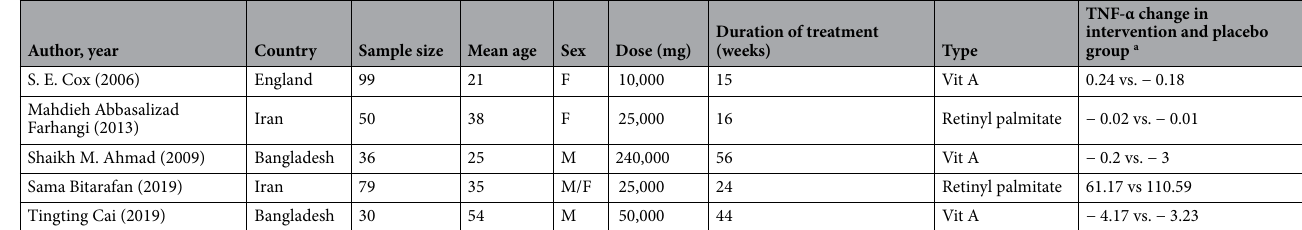
Table 2. The characterized of studies that included TNF-α analysis. Summary of clinical trials on the effects of vitamin A supplementation on inflammatory biomarker (TNF-α). TNF-α tumour necrosis factor-α, M male, F female, a Changes in cytokine concentrations are presented by common units for TNF-α (pg/mL).